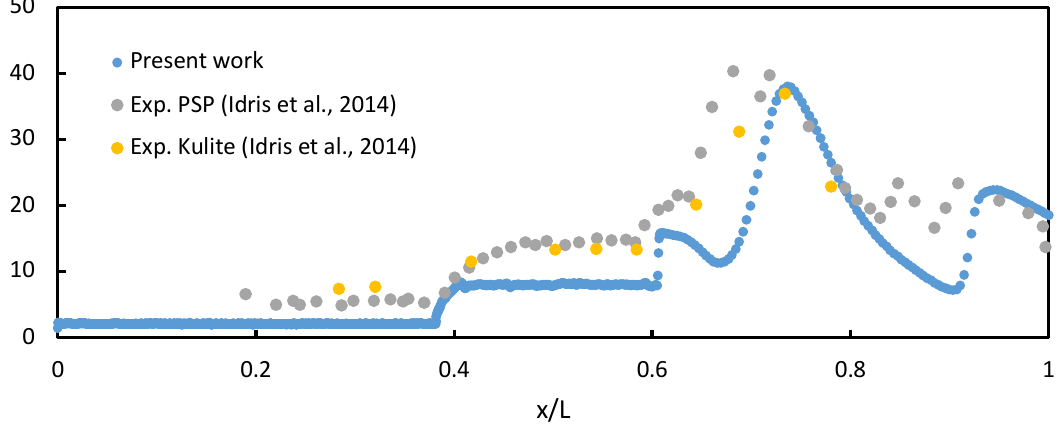
Figure 4. Validation of present simulation work with published experimental results [47].